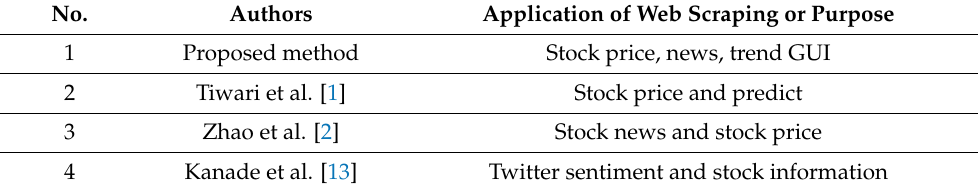
Table 2. Stock scraping comparative related work.